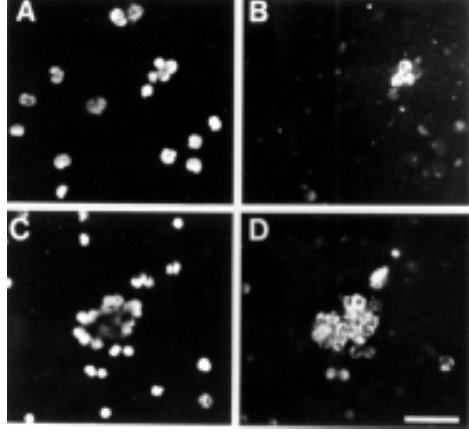
Figure 3 - Induction of dye cou- pling between macrophage cells. In cultures of (B) rat micro- glia treated for 3 h with the cal- cium ionophore 8Br-A23187 (2 µM) or (D) murine